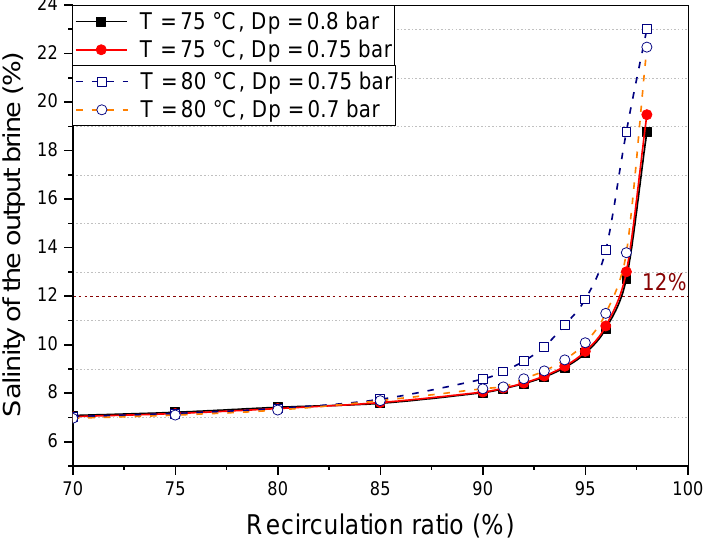
Figure 11. Salinity of the liquid outlet brine as the recirculation ratio increases, for two set-points at ∆ p = 0.7, 0.75 and 0.8 Δ p = 0.7, 0.75 and 0.8 bar.